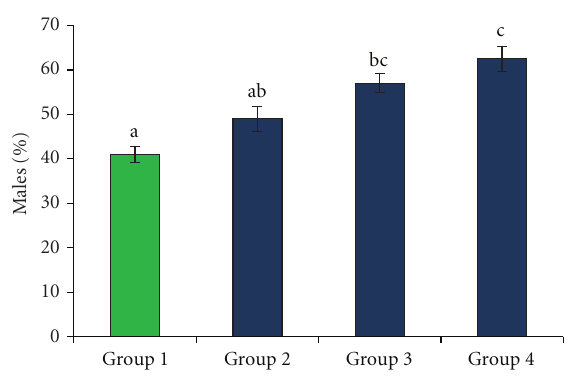
Figure 5: The percentages of males produced in the control group and in the three groups exposed to elevated temperature. Data represent the mean ± SEM. Data labeled with di ff erent letters are significantly di ff erent at P < 0 . 01.